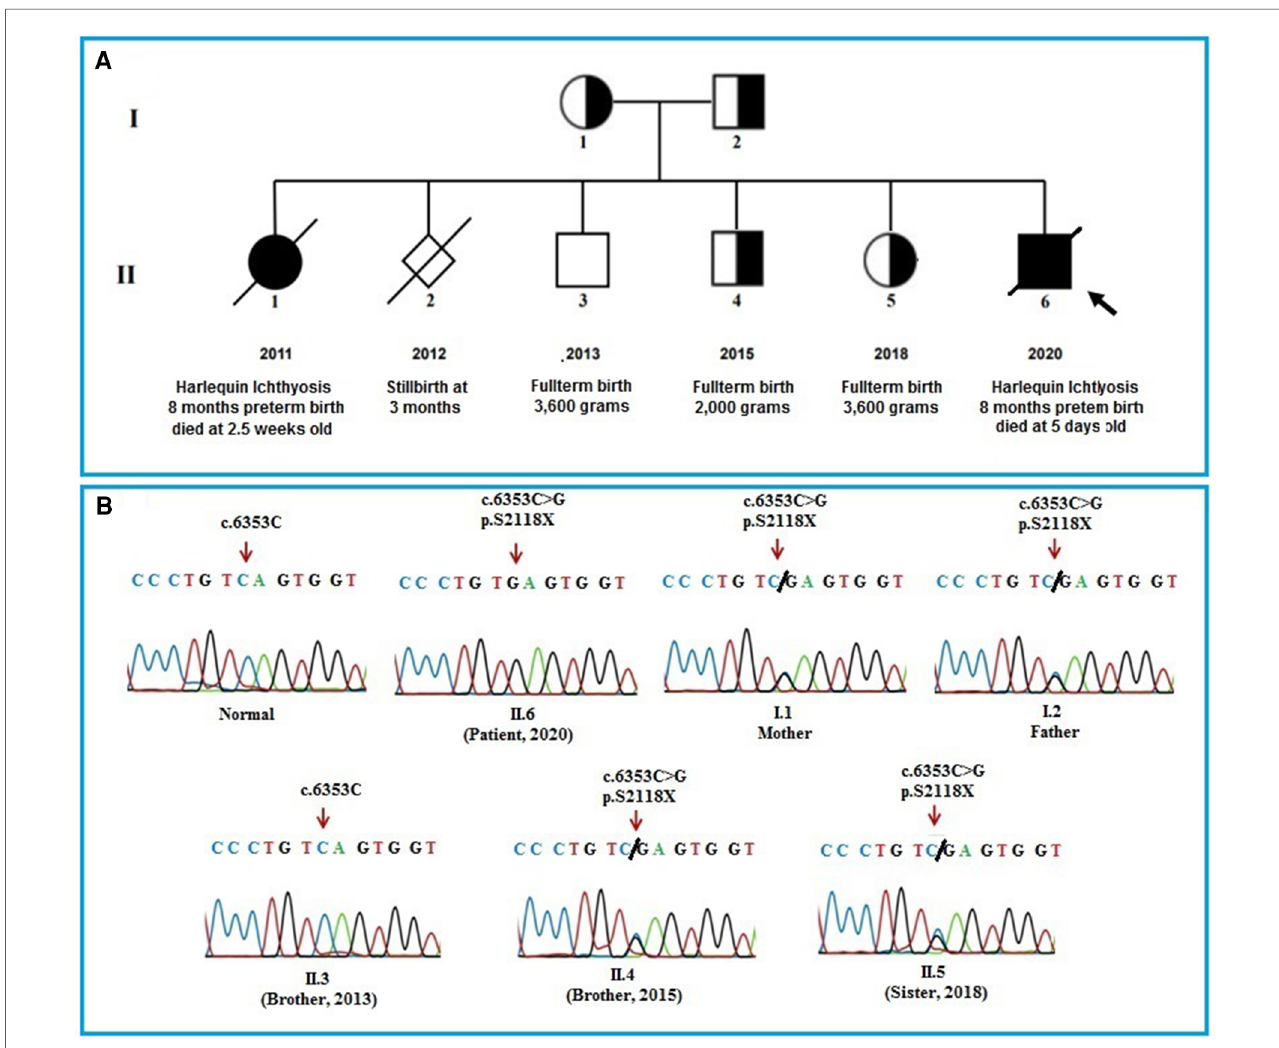
FIGURE 2 ( A ): pedigree of the patient ’ s family. The pedigree of the patient ’ s family including parents, a sister who died of HI disease, a stillbirth boy at 12 weeks of prenancy, a healthy brother, a brother and a sister who carrying the mutation and the patient. ( B ): The Sanger sequencing results of the members in the patient ’ s family. The results show that the patient ’ s parents, an older brother, and an older sister carry a heterozygous mutation (c.6353C>G) in the ABCA12 gene. The patient bear the homozygous mutation (c.6353C>G) and the other healthy brother who was born in 2013 does not have the